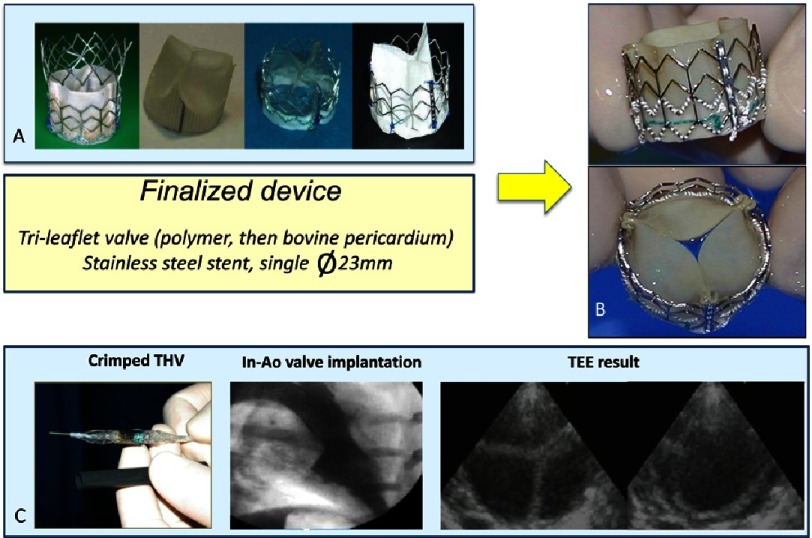
A: Various prototypes and finalized device (B) created by PVT.C: Crimped device over a 23 mm Numed balloon catheter, and 24F introducer for implantation in the sheep model. Angiographic evaluation post-implantation within the native aortic valve, and transesophageal echocardiography evaluation of valvular function.